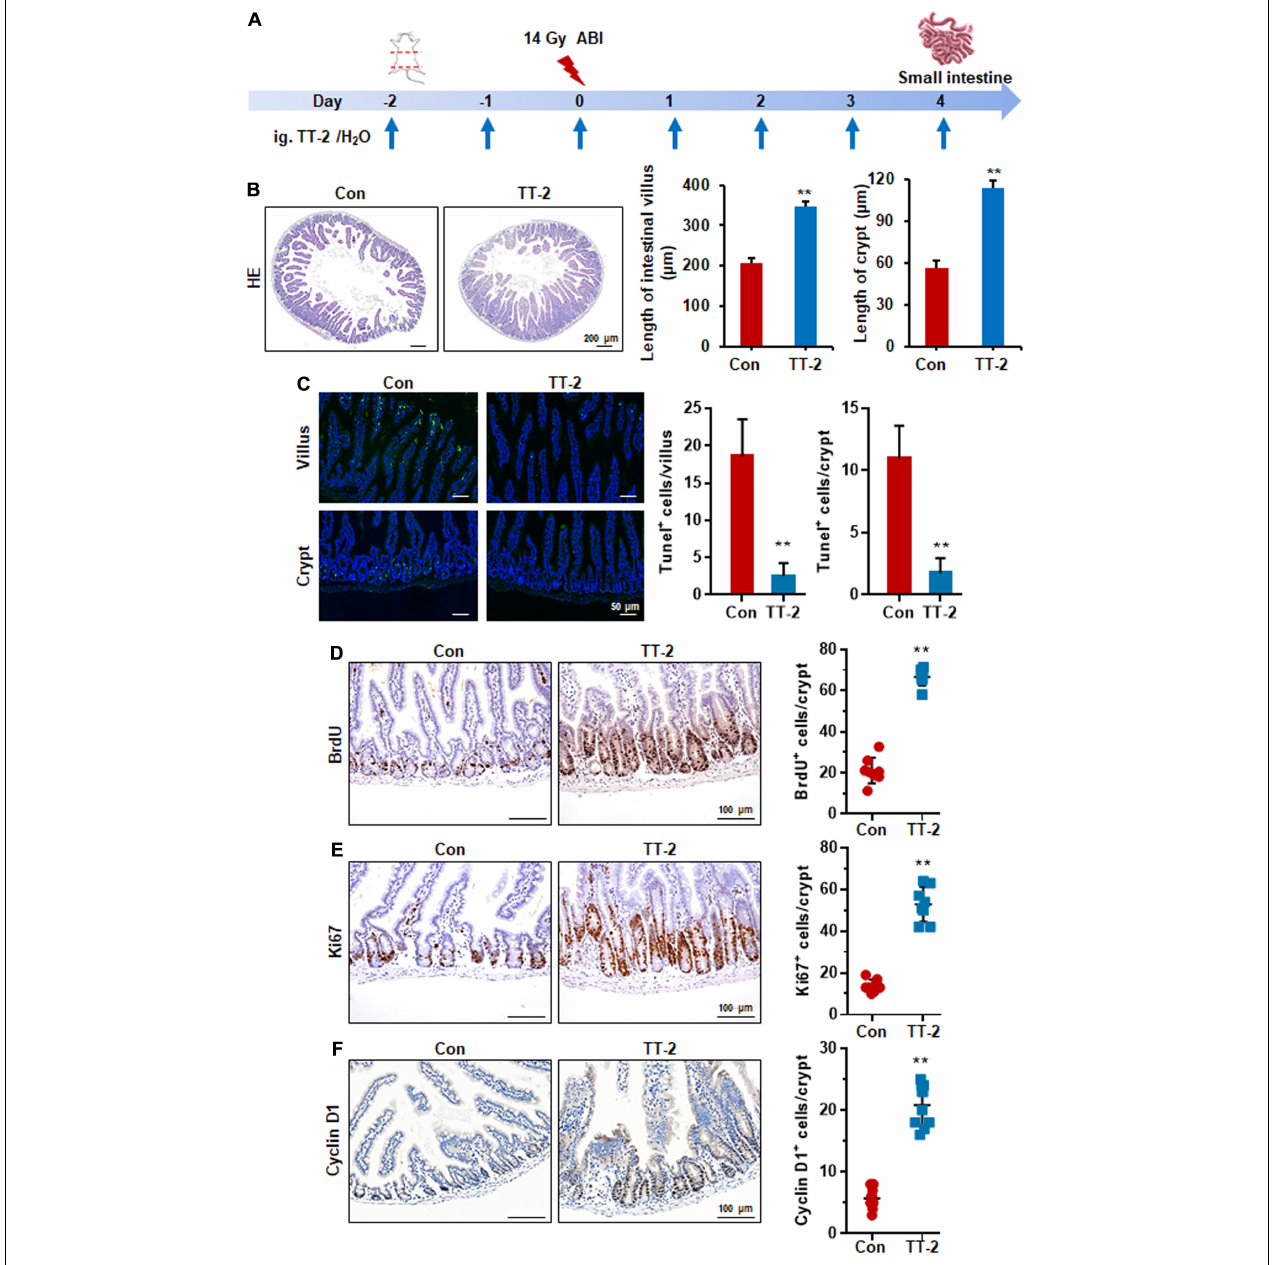
FIGURE 4 | TT-2 promoted proliferation of small intestinal epithelial cells. (A) Time schedule for TT-2/H 2 O oral administration to mice after 14 Gy irradiation. (B) Representative H&E-stained sections and quantification of villus and crypt length 4 days after irradiation (** p < 0.01, scale bar = 200 µ m). Three mice from each group were used. (C) Representative TUNEL-stained images and the quantification of the TUNEL + cells in the villus and crypt of the small intestine on day 4 after 14 Gy WBI and different treatments (** p < 0.01, Scale bar = 50 µ m). (D) Representative BrdU-stained sections and quantification of BrdU + cells in crypt of small intestine after 14 Gy ABI and different treatments (** p < 0.01, scale bar = 100 µ m). Three mice from each group were used. (E) Representative Ki67-stained sections and quantification of Ki67 + cells in crypt of small intestine after 14 Gy ABI and different treatments (** p < 0.01, scale bar = 100 µ m). Three mice from each group were used. (F) Representative Cyclin D1-stained sections and quantification of Cyclin D1 + cells in crypt of small intestine after 14 Gy ABI and different treatments (** p < 0.01, scale bar = 100 µ m). Three mice from each group were